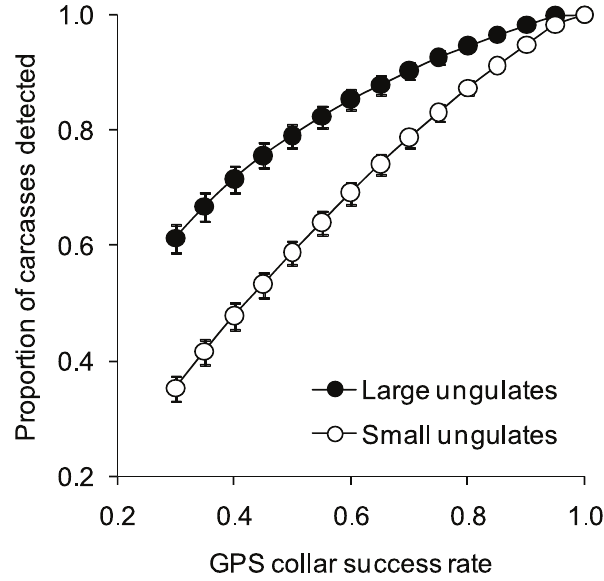
Figure 2. The influence of GPS collar success on carcass detection by individual wolves. Simulated relationship between the proportion of GPS locations successfully acquired and the mean proportion of carcasses still detected ( n =183 large ungulate carcasses, n =174 small ungulate carcasses). Error bars represent standard errors, many of which are too small to see. The lines represent best fitting polynomial regressions: y =0.29 + 1.29 x – 0.58 x 2 ( R 2 =1.00, P , 0.0001) for large ungulates and y =– 0.08 + 1.59 x – 0.50 x 2 ( R 2 =1.00, P , 0.0001) for small ungulates.